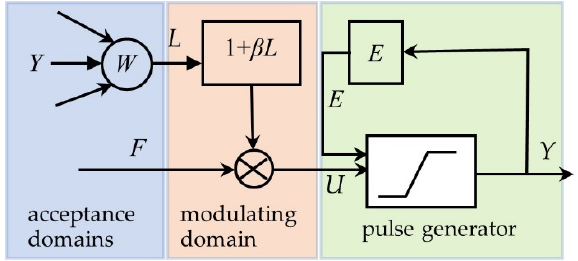
Figure 2. Structure of the PCNN model.